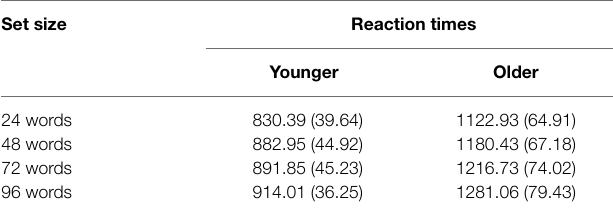
TABLE 2 | Reaction times for the recognition memory